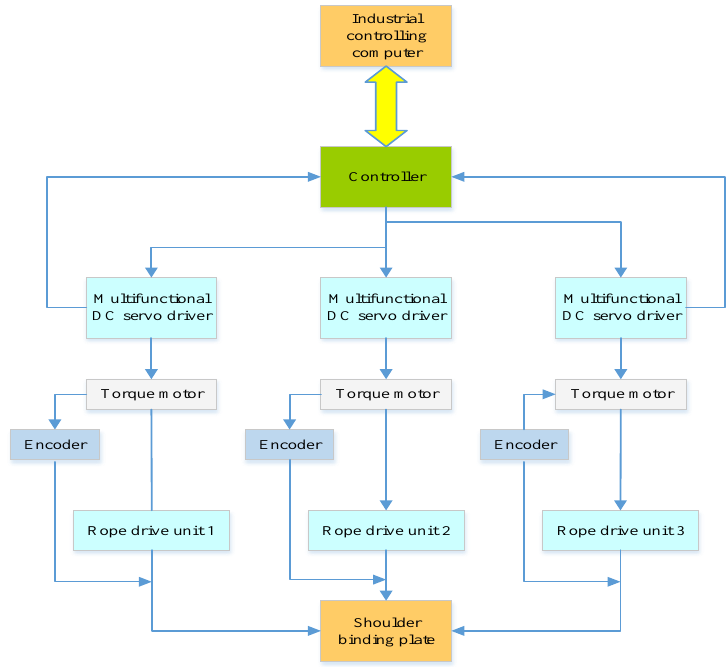
Figure 13. Control structure diagram of the rope traction part of the system.